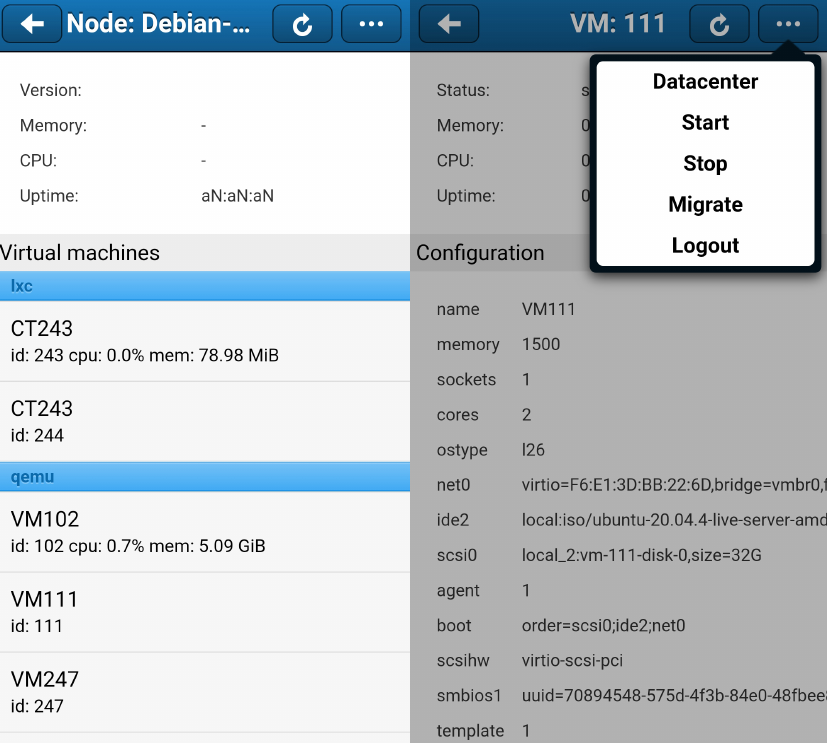
Figure 4: Mobile version of the Proxmox VE web